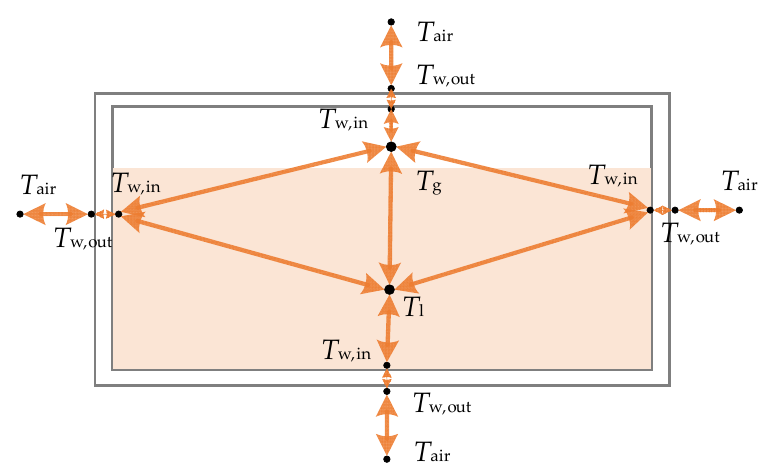
Figure 2. Curve of temperature change with time in tank. The temperature difference between the inlet and outlet was small, so each part of the tank was simplified into different nodes during the theoretical deduction, and the nodes were connected by heat conductors. The parameters of the nodes and heat conductors represent the temperature of the medium and the heat transfer mode between the media, respectively. At the same time, considering that a certain amount of air is usually reserved at the top of the hydraulic tank, therefore, the mathematical modeling of the hydraulic tank was divided into the “Oil contact part” and the “Air contact part” according to the different contact media of its inner wall, as shown in Figure 3.